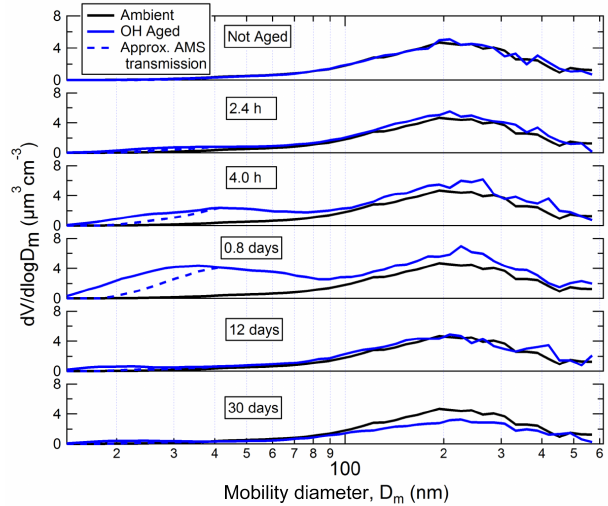
Figure 9. SMPS volume size distributions after OH oxidation using the OFR185 method, labeled by photochemical age and compared to concurrent ambient measurements. Each of the six OH-aged size distributions is an average of six SMPS scans from the night of 28–29 July, when relatively large OA enhancement was observed and the ambient aerosol dry surface area was in the range of 80– 100µm 2 cm − 3 . Dashed lines represent the approximate size distri- butions that were transmitted through the AMS aerodynamic lens (for which a correction was applied to reported OA values as dis- cussed in Sect. S3). Scans with large OA enhancement were used in order to more clearly illustrate the condensation vs. nucleation be- havior in the OFR, so the AMS lens transmission correction in this figure appears larger than average. All scans have been corrected for small particle losses to sampling lines (Sect. S1).